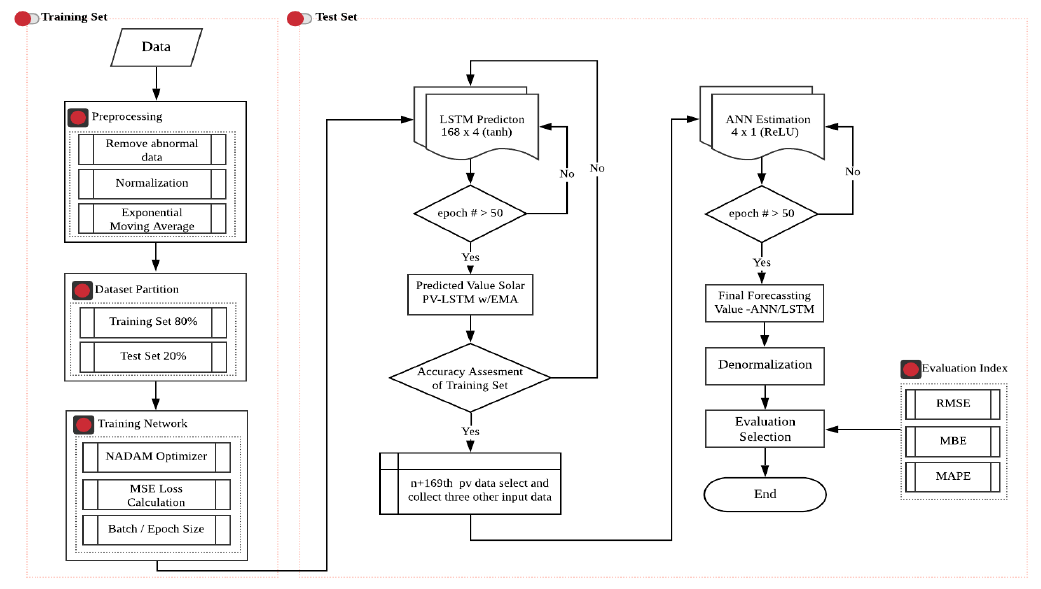
Figure 2. Flow chart of the two-stage neural network model (SolPV_ELA) for short-term forecasting of photovoltaic (PV) output power.